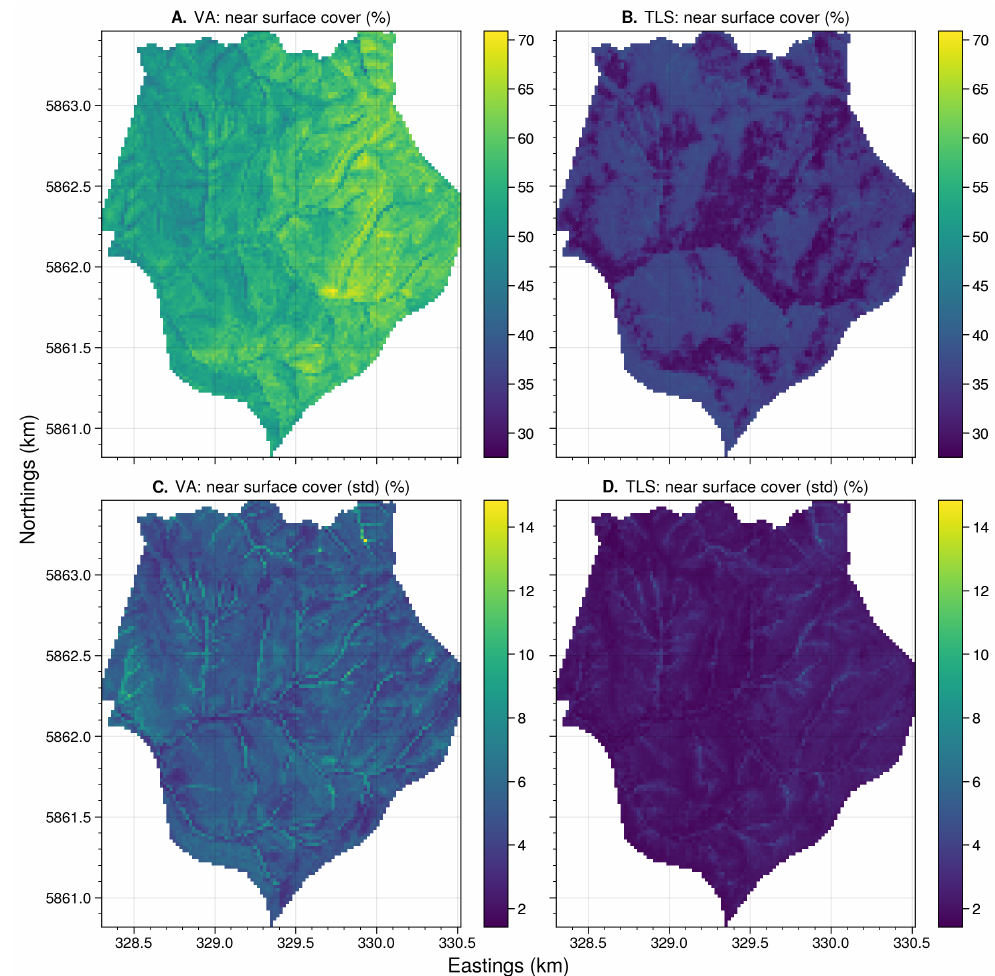
Figure 8. The mean and standard deviation of landscape level predictions for near-surface fuel cover using visual assessments ( A , C ) and TLS ( B , D ) at